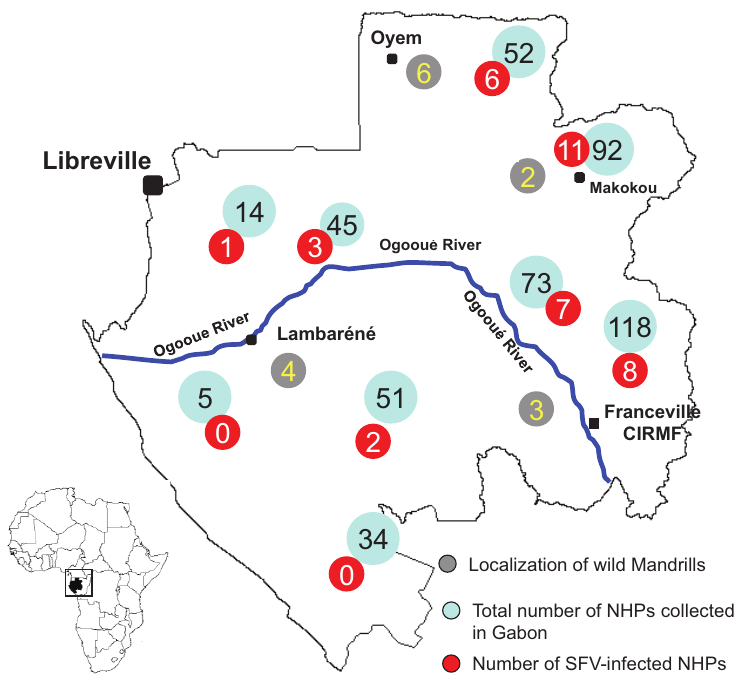
Figure 3. Map of Gabon with the location of SFV-positive wild mandrills. Samples collected from SFV-positive wild mandrills are shown in grey. The blue line represents the Ogooué